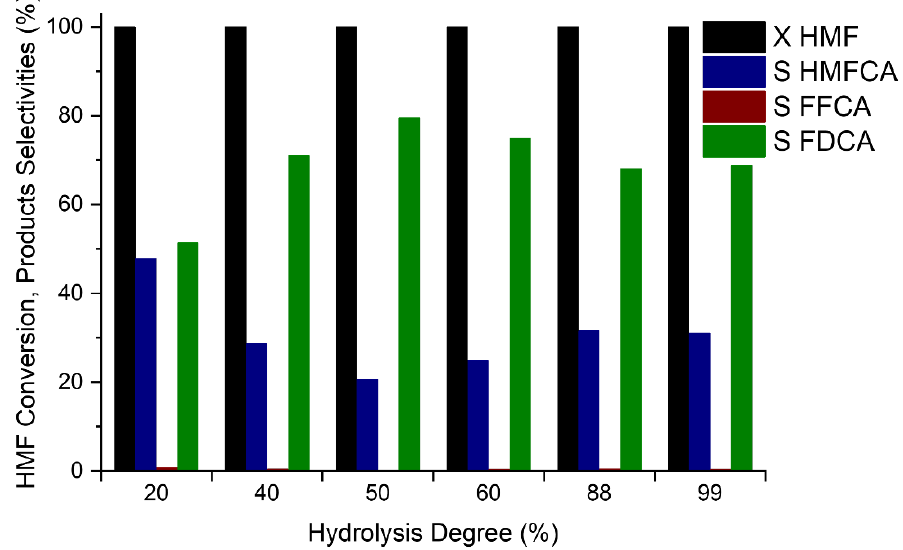
Figure 1. Effect of hydrolysis degree on the catalytic performances for HMF oxidation. Reaction conditions: T = 70 °C, t = 4 h, P = 10 bar O 2 , molar ratios HMF:Au:NaOH = 1:0.01:4.